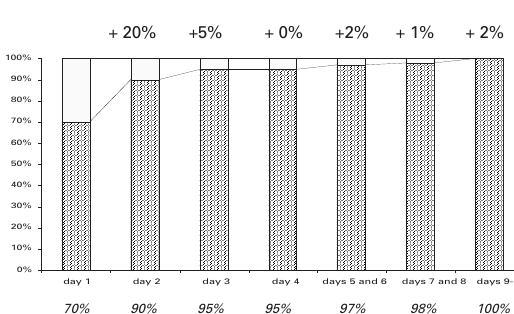
Estimated mortality risk according to the Zwolle score (7) The x axis gives the Zwolle score above, then the correspon- ding 30-days mortal- ity rate in the Zwolle population and then below the mortality rate in our study. The y axis gives the number of patients in every group.